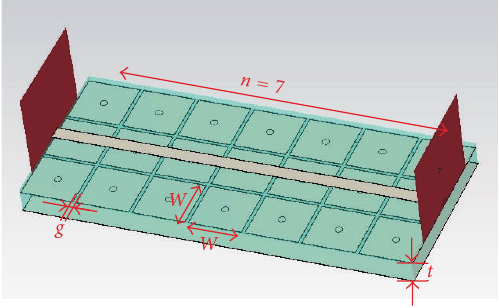
Figure 7: Simulation scheme for S 21 analysis.